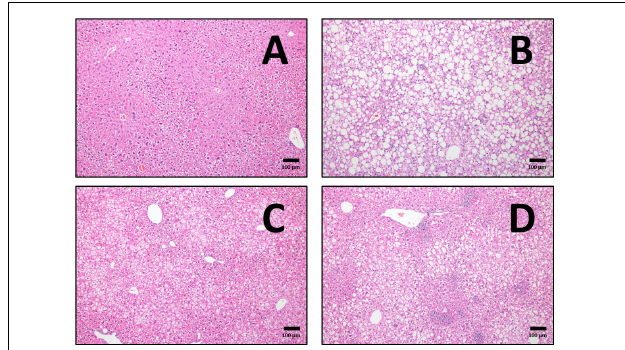
FIGURE 9 | Representative cross-sections of liver, with haematoxylin and eosin staining at 10 × magnifications for CHOW untrained (A) , high-fat fed untrained (B) , high-fat fed after endurance training (HFD+END; C ), and high-fat fed after high-intensity interval training (HFD+HIIT; D ). The effects of high-fat diet are clearly shown in (B) with the presence of lipid droplets, whereas both exercise programs induce a reduction in this finding. Since no major differences were seen in CHOW mice after exercise training, those images are not shown. The size bars indicate 100 µ m and images are at 10 ×